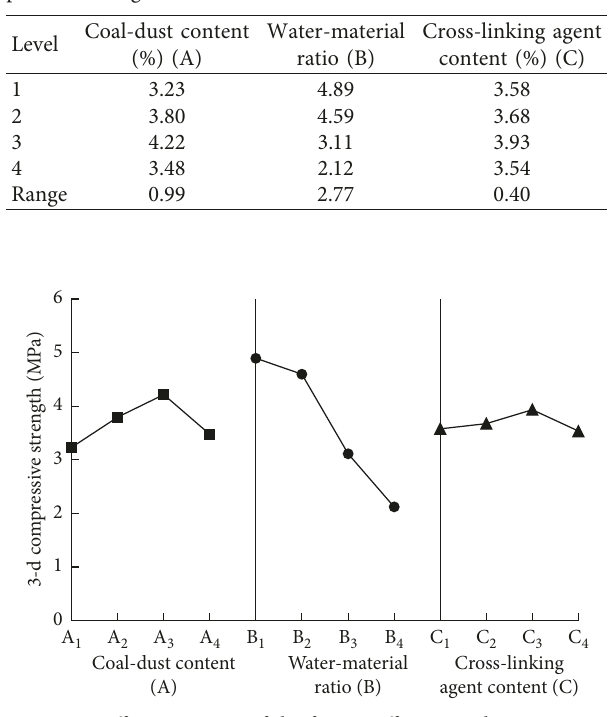
Figure 3: Effective curves of the factors affecting 3-d compressive